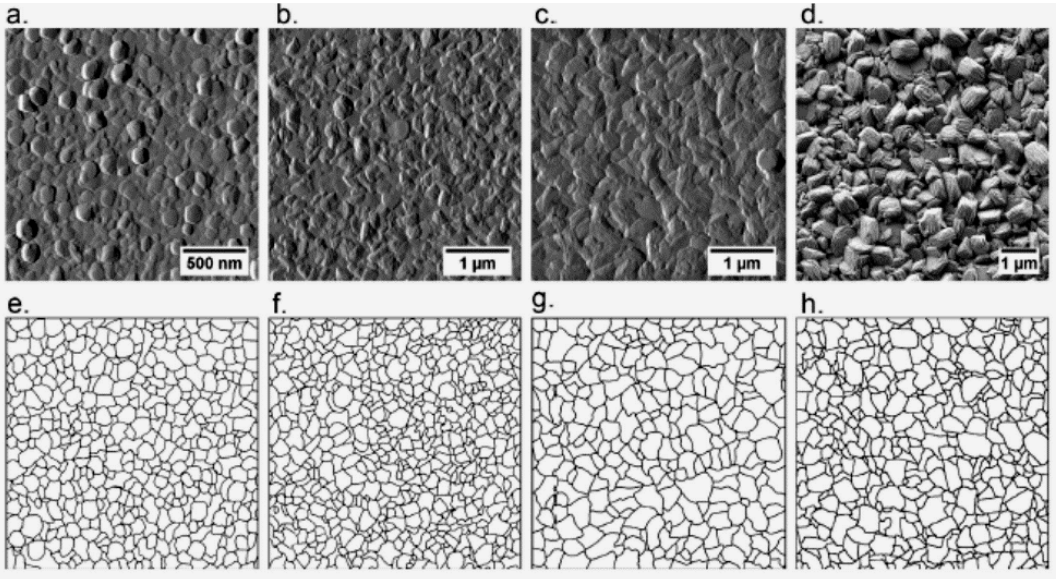
Figure 5. Representative in situ AFM and ex situ SEM images where ( a – c ) represents an AFM image (deflection) sequence of the zinc surface during electrodeposition within Zn(TfO) 2 /[BMIm][TfO] at a deposition overpotential of 445 mV vs. ECO after 400 Zn ML (418.4 mC ∙ cm − 2 ), 1200 Zn ML (1255.2 mC ∙ cm − 2 ), and 2800 Zn ML (2928.8 mC ∙ cm − 2 ) of chargé passed, and ( d ) is a representative SEM image from the Zn surface after electrodeposition within Zn(TfO) 2 /[BMIm][TfO] within the USAXS cell after 3600 Zn ML (1882.8 mC ∙ cm − 2 ) of charge passed. The observed domains are outlined for the corresponding AFM and SEM images in ( e – h ). [Reproduction with permission from Keist, J.S.;